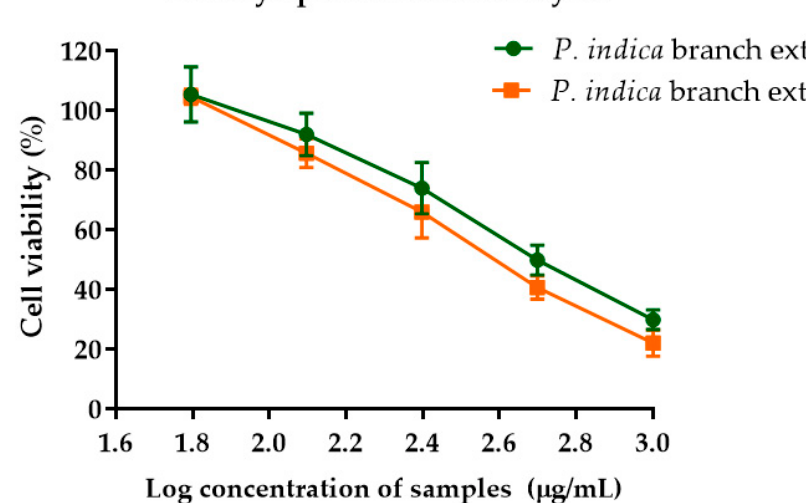
Table 1. IC 50 values of P. indica branch extract and NPs.